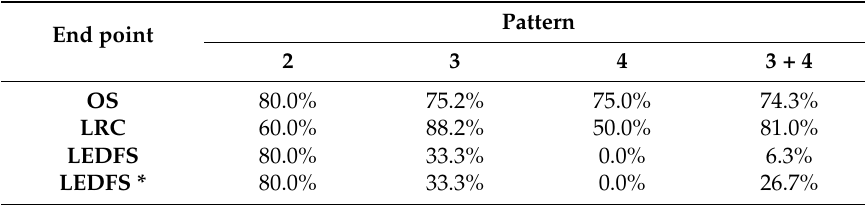
Table 4. Three-year LEDFS